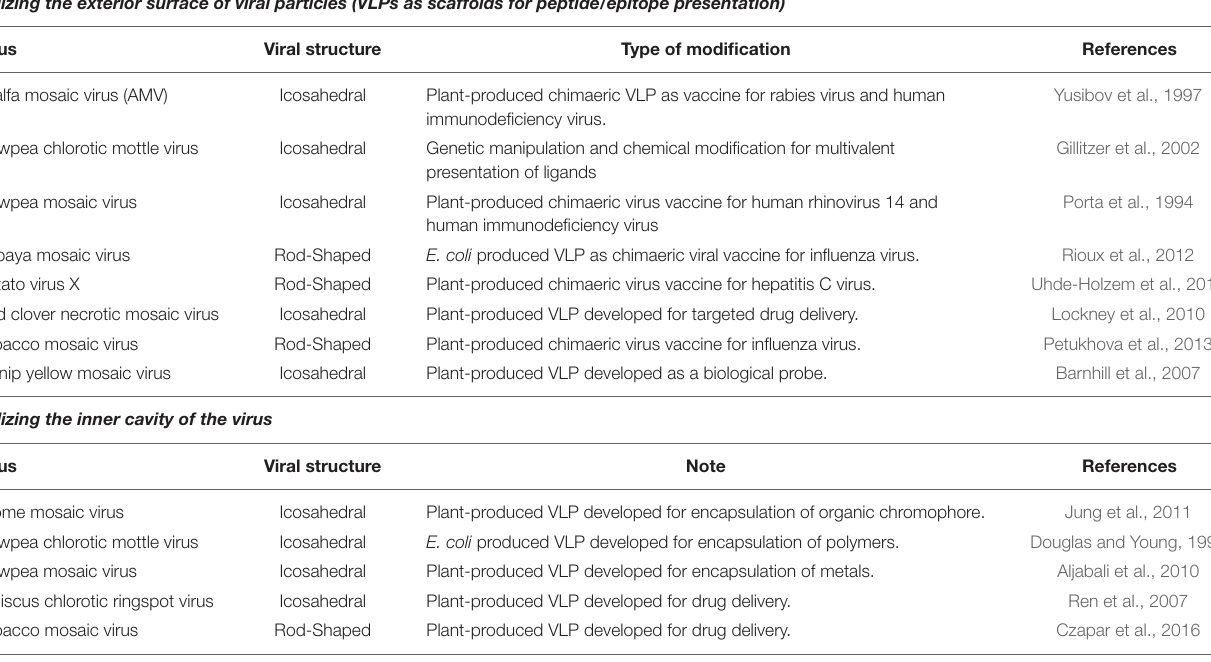
FIGURE 4 | Various filamentous plant viruses engineered for different biological applications. TABLE 3 | List of some of the non-enveloped plant viruses that have been produced for VLP or VNP applications. Utilizing the exterior surface of viral particles (VLPs as scaffolds for peptide/epitope